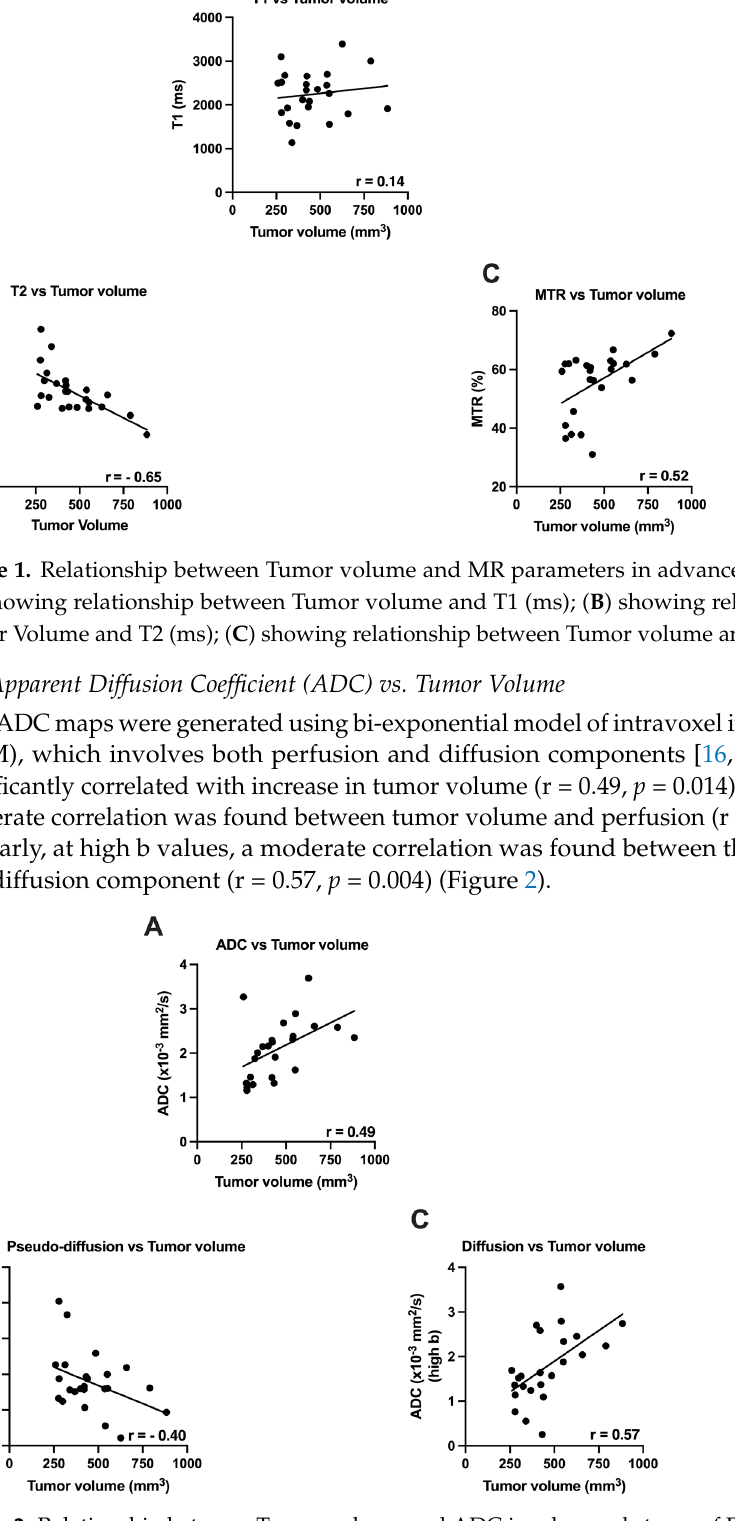
Figure 2. Relationship between Tumor volume and ADC in advanced stages of PDAC. ( A ) showing relationship between Tumor volume and ADC (mm 2 /s); ( B ) showing relationship between Tumor Volume and ADC low b values (pseudo-diffusion); ( C ) showing relationship between Tumor volume and ADC (high b values).